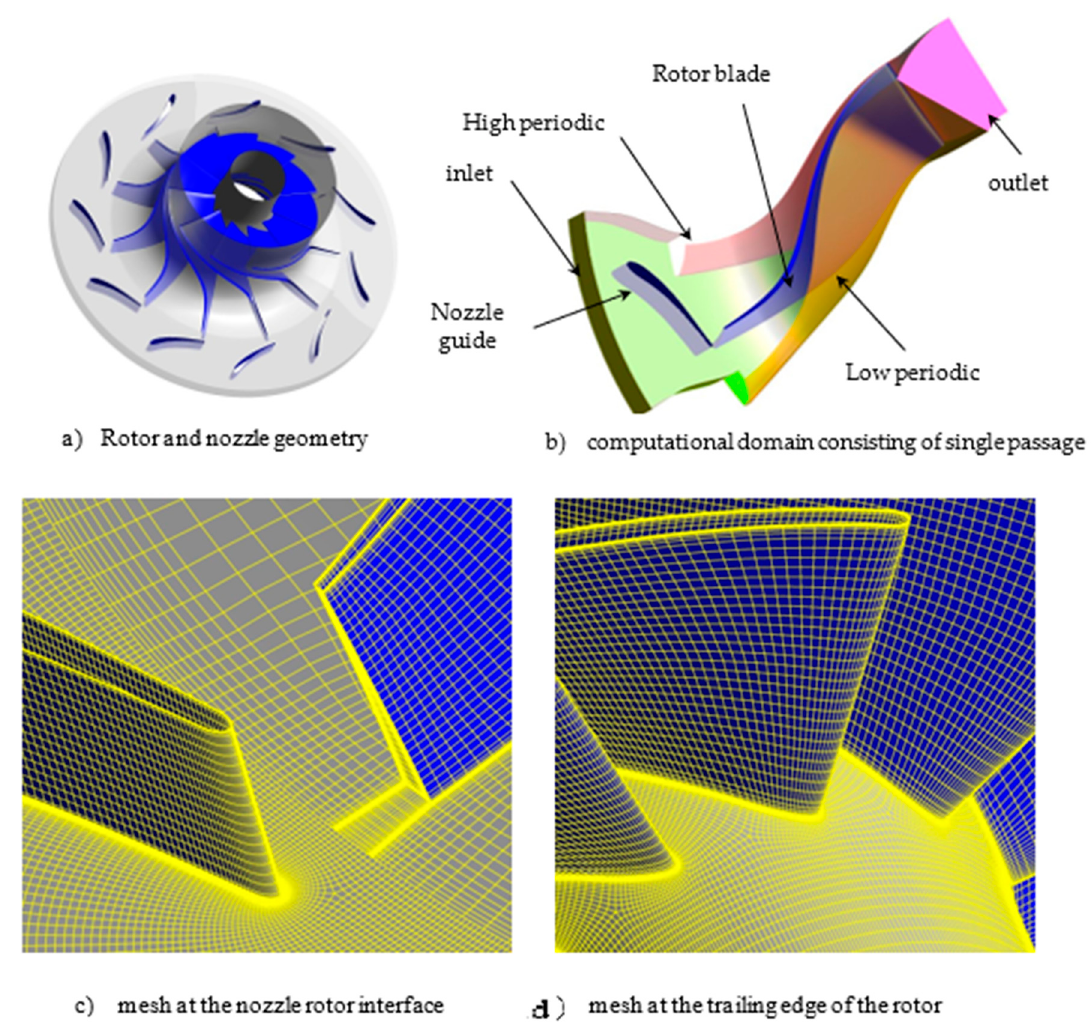
Figure 6. Cmputational geometry and mesh.